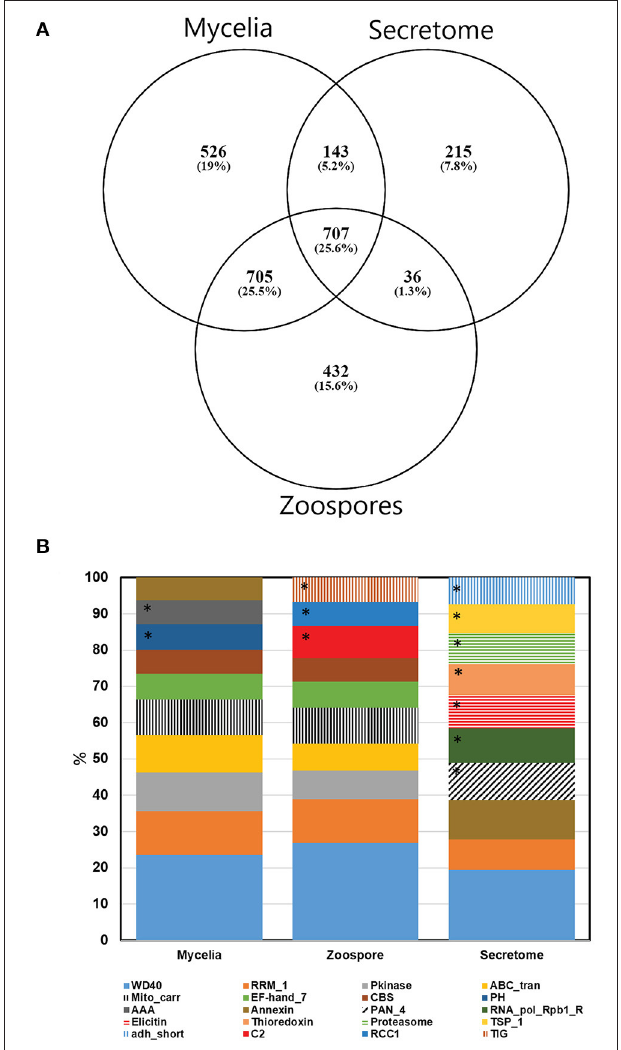
FIGURE 4 | Criteria for gene editing and discovery. (A) Peptides matching to 6-frame open reading frames in loci with no surrounding genes or out of frame from surrounding genes and returned significant BLASTp hits were manually annotated as new genes. (B) Peptides overlapping boundaries of multiple genes within the same frame and returned significant BLASTp hits were used to manually merged genes. (C) Genes with in frame peptides overlapping boundaries and returned significant BLASTp hits were manually